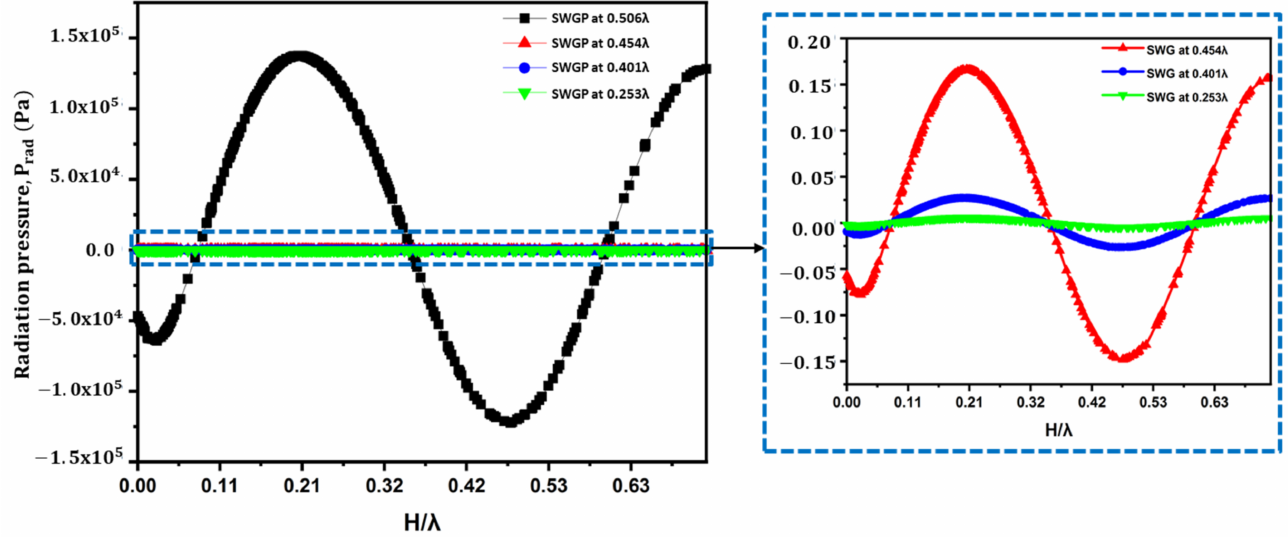
Figure 7. Numerical simulation results of standing wave radiation pressure at acoustic cavity of height, H when the SWGP was actuated at 0.506 λ (upper surface of the standing wave-source chamber), 0.454 λ , 0.401 λ , and 0.253 λ .